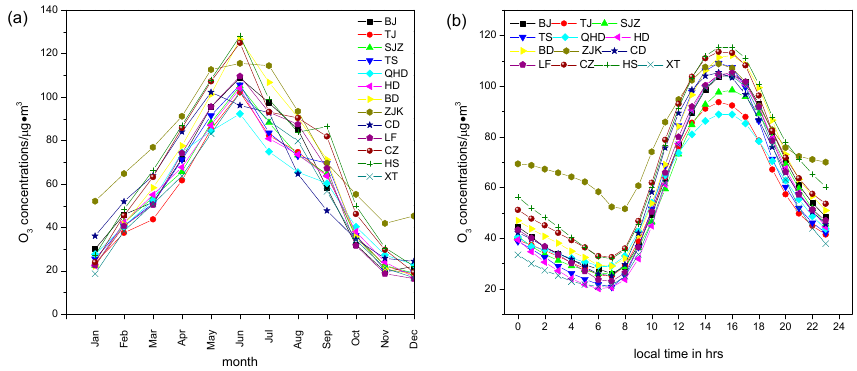
Figure 3. Inter ‐ annual variability of surface ozone (O 3 ) concentrations in BTH area.